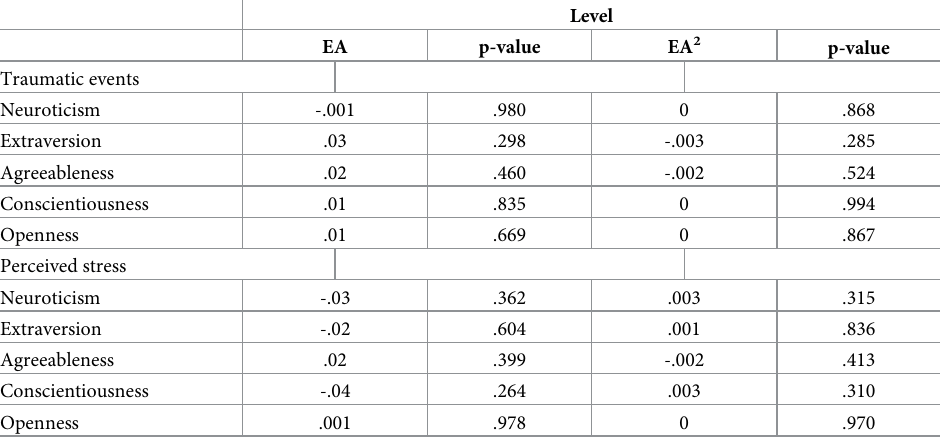
Table 6. Parameter estimates of the linear and quadratic moderating effects of early adversity on the covariances between adulthood stressors exposure and adulthood perceived stress and personality traits in the MIDUS sample.